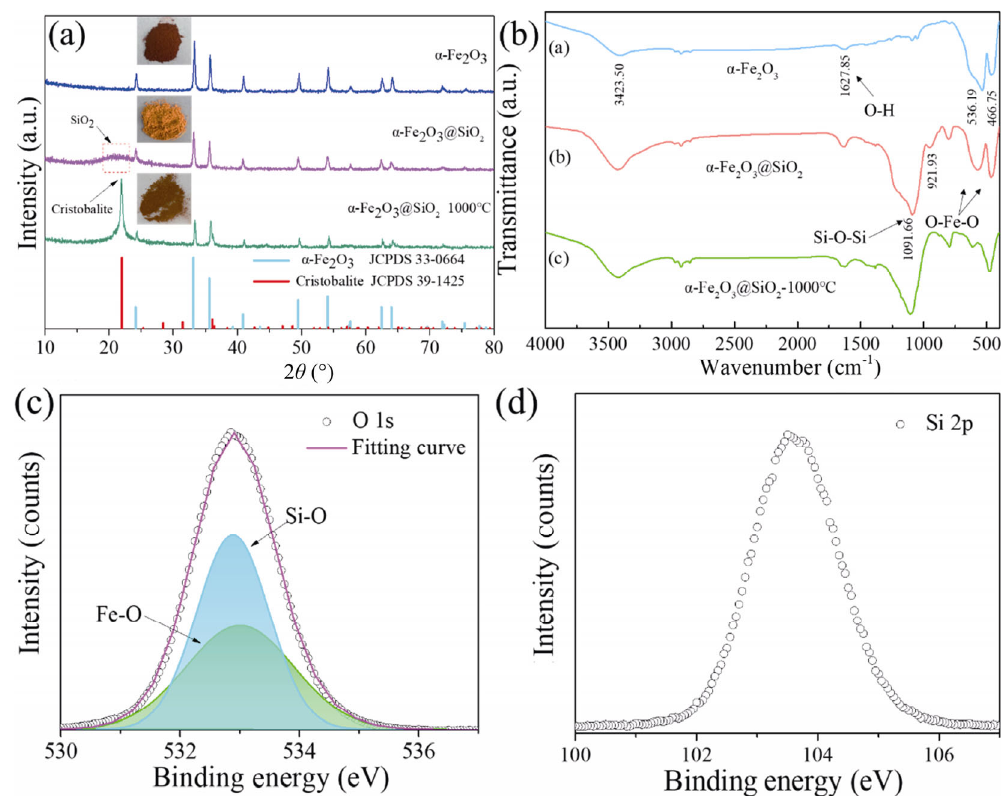
Fig. 4 (a) XRD patterns of the samples; (b) FTIR spectra of the samples; high-resolution XPS spectra of (c) O 1s and (d) Si 2p of the α-Fe 2 O 3 @SiO 2 pigments calcined at 1000 ℃ .